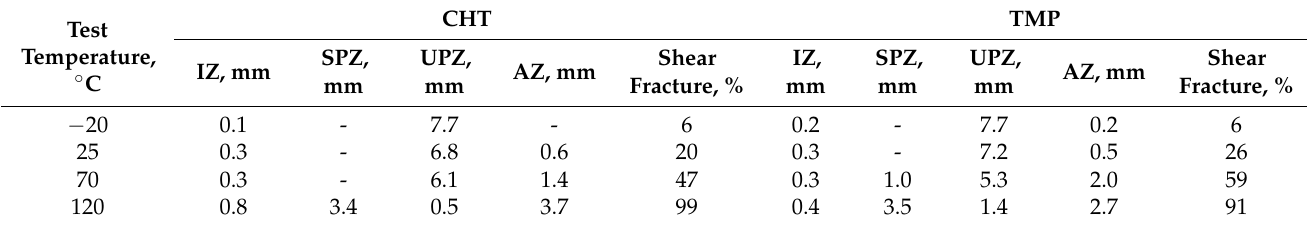
Table 5. The sizes of the fracture zones and percentages of the shear fracture